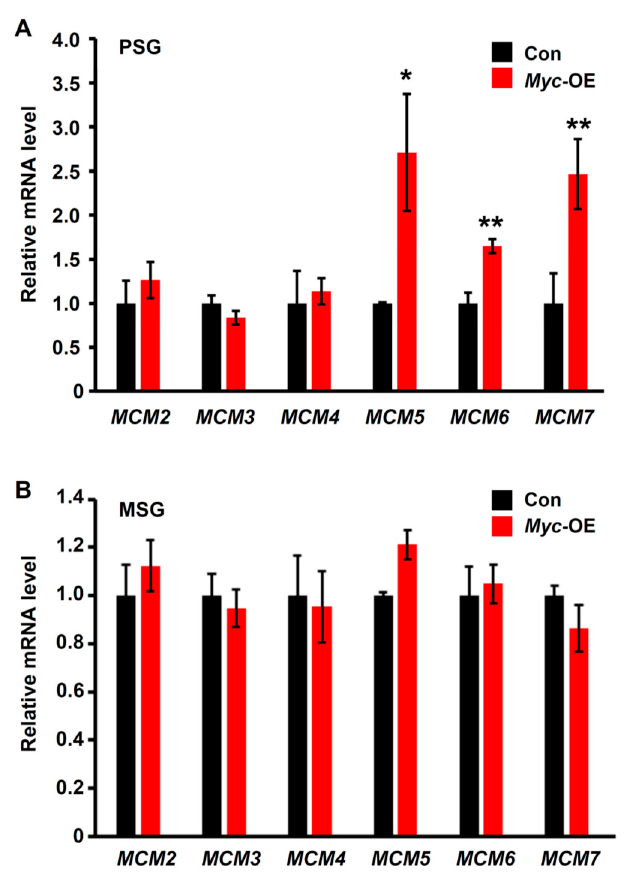
Figure 4. Myc positively regulates the transcription of the MCM genes. ( A ) RT-qPCR examination showed that PSG-specific Myc overexpression upregulated the transcription of the MCM genes in the PSG. ( B ) PSG-specific Myc overexpression had no effect on the transcription of the MCM genes in the MSG. Values are represented as means ± S.E. (error bars). For the significance test: * p < 0.05, ** p < 0.01 vs. control.